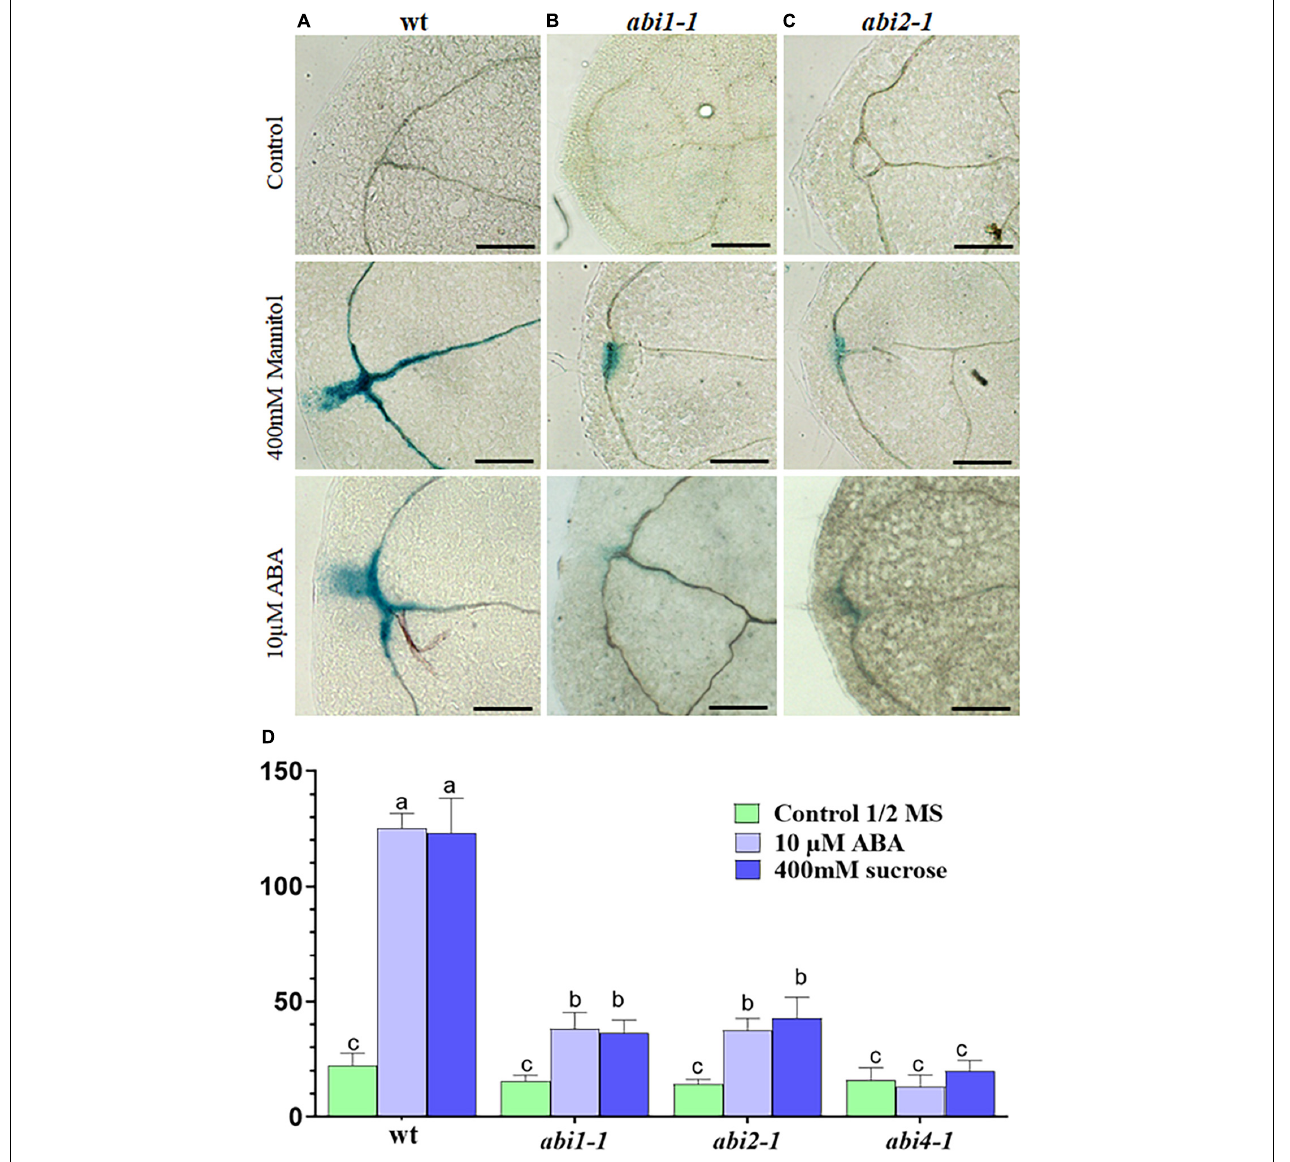
FIGURE 3 | RabA2b promoter activity in abi mutants during water stress. (A–C) GUS enzymatic activity visualization and (D) histochemical staining quantification of transgenic Arabidopsis plant expressing GUS gene driven by AtRabA2b promoter in wt, abi1.1 and abi2.1 plants, 12-h after osmotic stress (400 mM sucrose) or 10 µ M ABA. The experiment was performed three times, on three independent T3 homozygous lines. Images were captured to quantify GUS staining using ImageJ software as mentioned in Section “Materials and Methods.” The error bar in (D) indicates the standard error (SE) and significant differences between MS control, 400 mM sucrose and 10 µ M ABA treated conditions were assessed with 2-way ANOVA multiple comparisons ( P < 0.05). The letters (a, b,c) indicate the significant difference at p ≤ 0.05 Scale bar = 200 µ